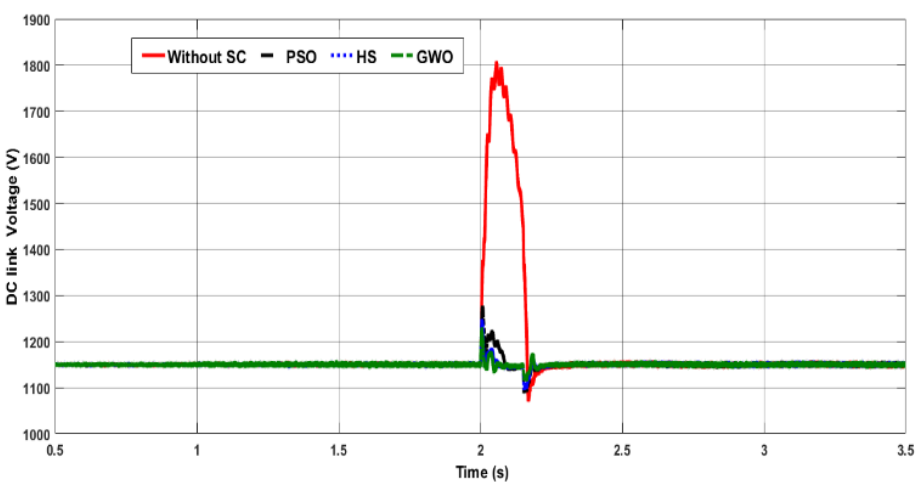
Figure 10. PCC voltage profile during the three-phase fault case study.